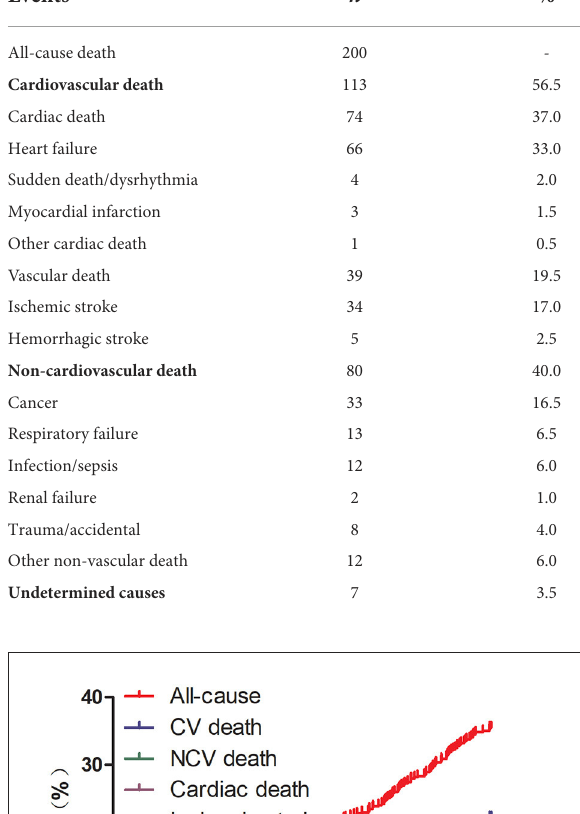
TABLE 2 Causes of death in patients with atrial fibrillation.